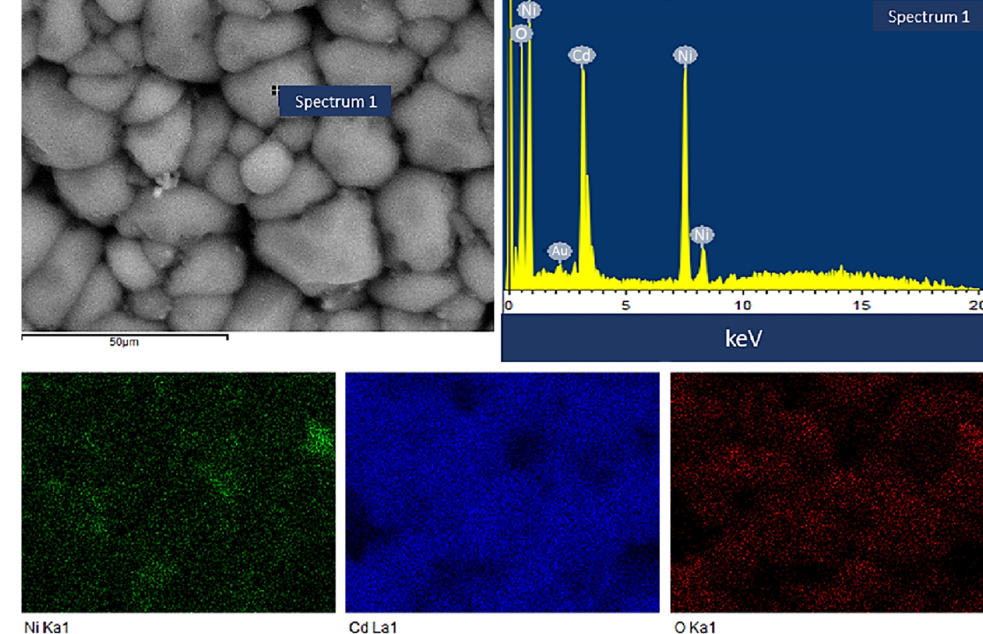
Figure 5. The EDX spectrum of the prepared sample was calcined at 700 °C.